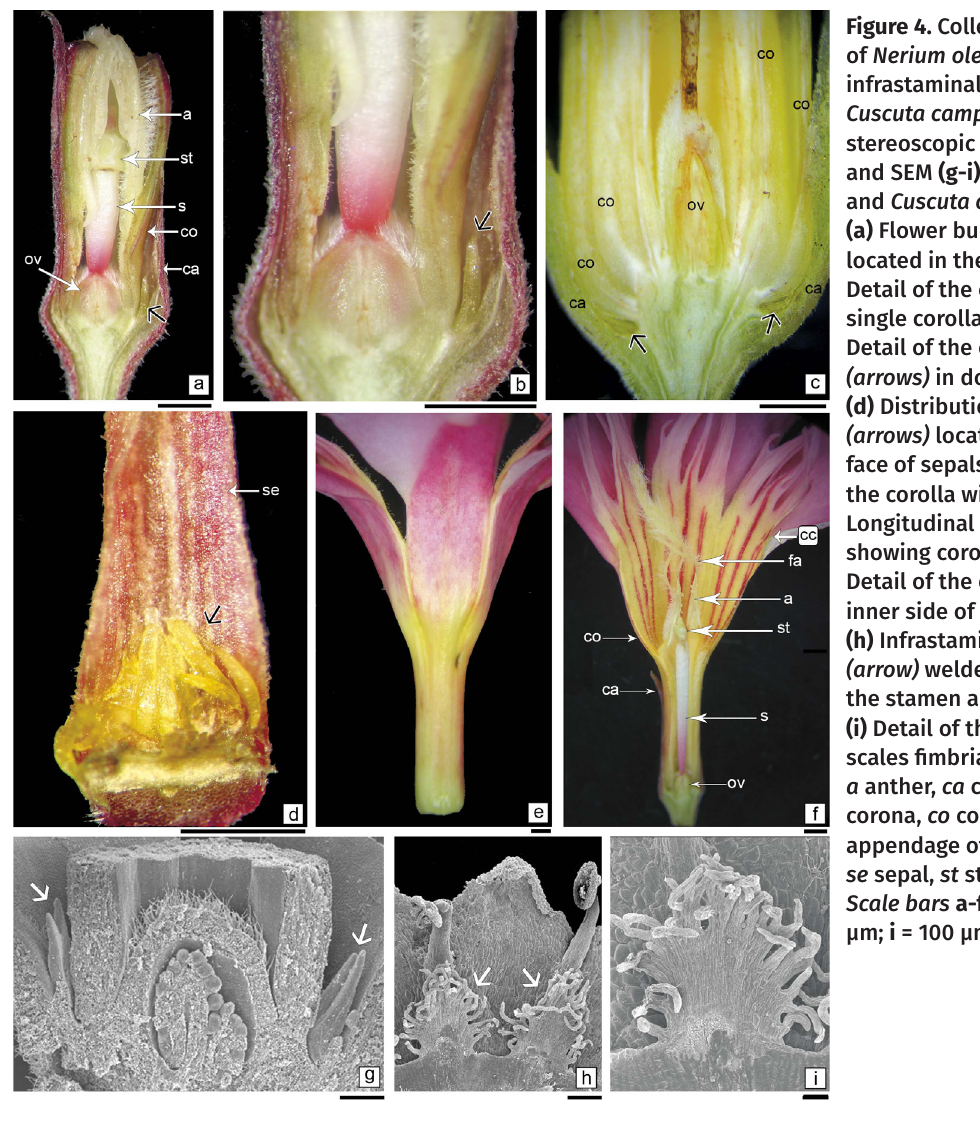
Figure 4. Colleter in the sepal of Nerium oleander and infrastaminal scales fimbriae in Cuscuta campestris seen with stereoscopic microscope (a-f) and SEM (g-i) . N. oleander (a- g) and Cuscuta campestris (h-i) . (a) Flower bud with colleter located in the calyx (arrow). (b) Detail of the callicine colleter in single corolla flower (arrow) . (c) Detail of the callicine colleter (arrows) in double corolla flower. (d) Distribution of the colleters (arrows) located in the inner face of sepals. (e) Outer side of the corolla without colleters. (f) Longitudinal section of flower showing corona position. (g) Detail of the colleter on the inner side of the sepal (arrows) (h) Infrastaminal scales fimbriae (arrow) welded to the base of the stamen and the corolla. (i) Detail of the infrastaminal scales fimbriae. Abbreviations: a anther, ca calyx, cc corolline corona, co corolla, fa feathery appendage of the anther, s style, se sepal, st stigma, ov ovary. Scale bars a-f = 1 mm; g, h = 300 µm; i = 100